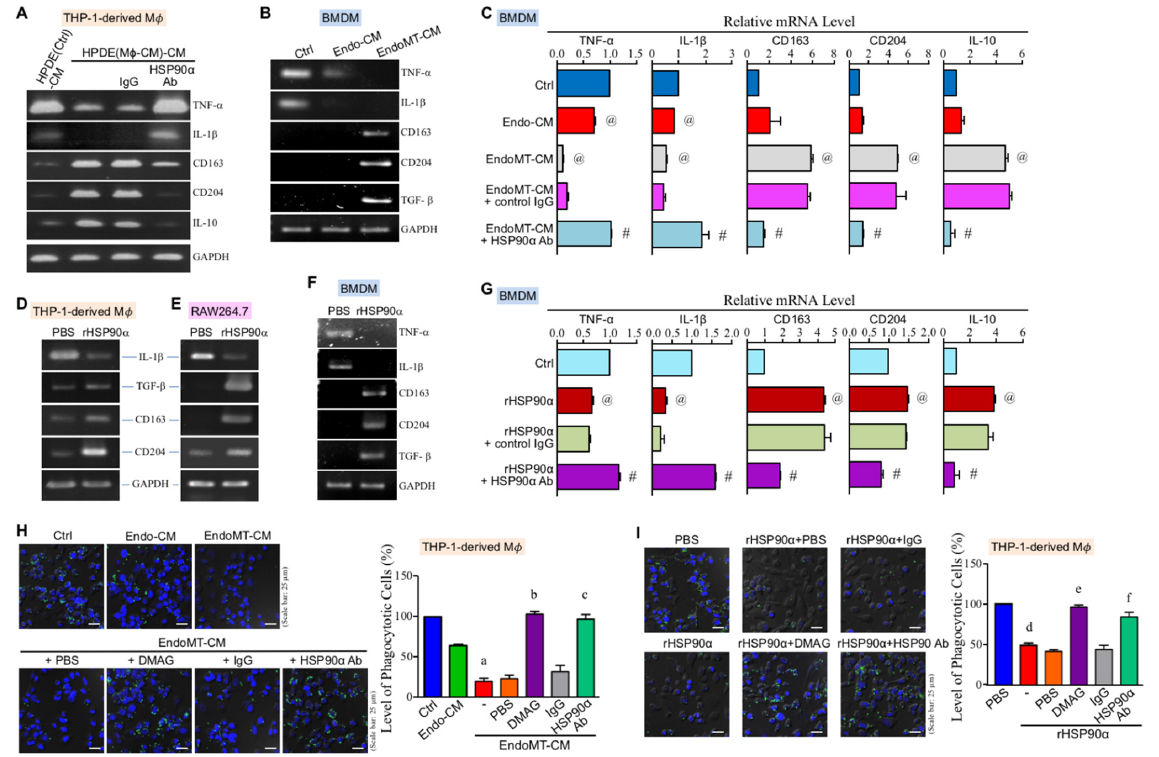
Figure 1. eHSP90 α induces M2-type polarization of macrophages. ( A ) mRNA levels of TNF- α , IL-1 β , CD163, CD204, and IL-10 in the THP-1-derived macrophages treated for 24 h with HPDE(Ctrl)-CM or HPDE(M φ -CM)-CM in the absence or presence of 10 µ g/mL control IgG or anti-HSP90 α antibody (LTK Biotechnologies, Taoyuan, Taiwan [14]). The representative RT-PCR data of three independent experiments are shown. ( B ) mRNA levels of TNF- α , IL-1 β , CD163, CD204, and TGF- β in the BMDMs treated for 24 h with control medium (Ctrl), Endo-CM, or EndoMT-CM. The representative RT-PCR data of three independent experiments are shown. ( C ) mRNA levels of TNF- α , IL-1 β , CD163, CD204, and IL-10 in the BMDMs treated for 24 h with control medium (Ctrl), Endo-CM, EndoMT-CM, or EndoMT-CM plus 10 µ g/mL of control IgG or anti-HSP90 α antibody. The mean ± SD of qPCR data were obtained from three independent experiments. @ p < 0.01 when compared with “Ctrl” group. # p < 0.01 when compared with “EndoMT-CM + control IgG” group. ( D , E ) mRNA levels of IL-1 β , TGF- β , CD163, and CD204 in the THP-1-derived macrophages ( D ) or RAW264.7 cells ( E ) treated for 24 h with PBS or 15 µ g/mL of rHSP90 α . The representative RT-PCR data of three independent experiments are shown. ( F ) mRNA levels of TNF- α , IL-1 β , CD163, CD204, and TGF- β in the BMDMs treated for 24 h with PBS or 15 µ g/mL of rHSP90 α . The representative RT-PCR data of three independent experiments are shown. ( G ) mRNA levels of TNF- α , IL-1 β , CD163, CD204, and IL-10 in the BMDMs treated for 24 h with PBS (Ctrl), 15 µ g/mL of rHSP90 α , or rHSP90 α plus control IgG or anti-HSP90 α antibody. The qPCR data shown are the mean ± SD of three independent experiments. @ p < 0.01 when compared with “Ctrl” group. # p < 0.01 when compared with “rHSP90 α + control IgG” group. ( H ) Phagocytotic activities of the THP-1-derived macrophages treated for 24 h with control medium (Ctrl), Endo-CM, EndoMT-CM, or EndoMT-CM plus PBS, 1 µ M of DMAG-N-oxide, control IgG, or anti-HSP90 α antibody. The quantitative data are the mean ± SD of three independent experiments. a p < 0.01 when compared with “Ctrl” group. b p < 0.01 when compared with “EndoMT-CM + PBS” group. c p < 0.01 when compared with “EndoMT-CM + IgG” group. ( I ) Phagocytotic activities of the THP-1-derived macrophages treated for 24 h with PBS or rHSP90 α in the absence or presence of DMAG-N-oxide or anti-HSP90 α antibody. The quantitative data are the mean ± SD of three independent experiments. d p < 0.01 when compared with “PBS” group. e p < 0.01 when compared with “rHSP90 α + PBS” group. f p < 0.01 when compared with “rHSP90 α + IgG”